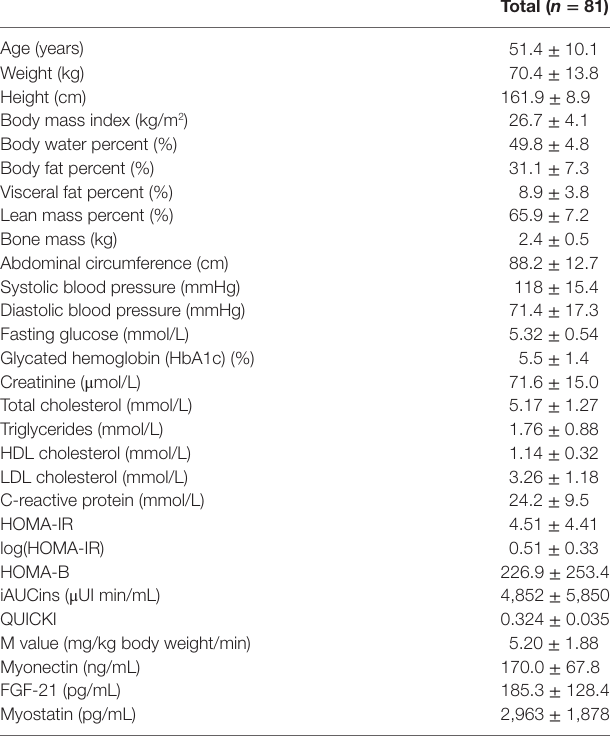
TaBle 1 | Characteristics of study